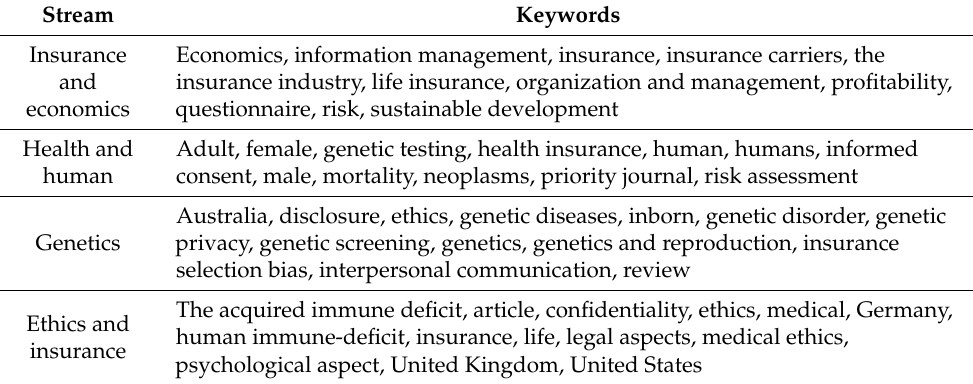
Figure 7. Clusters of keywords with at least 6 occurrences. Table 7. Current